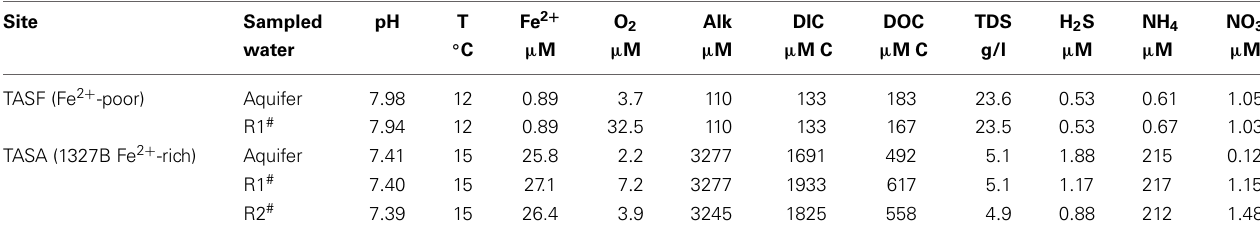
Table 1 | Physico-chemical characteristics of the different aquifers connected to the reactors.